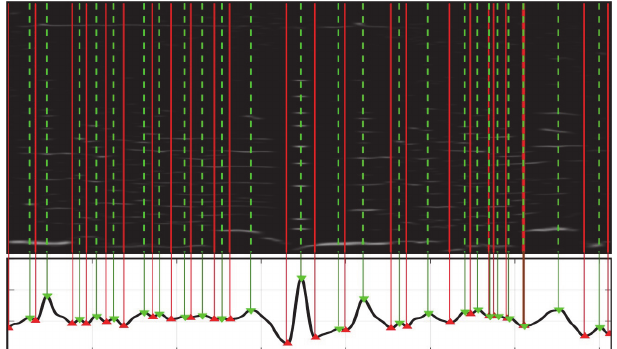
Fig. 3. Result of division into vertical bars of one of 2DE gel images according to the location of local minima and local maxima in the horizontal distribution of intensity